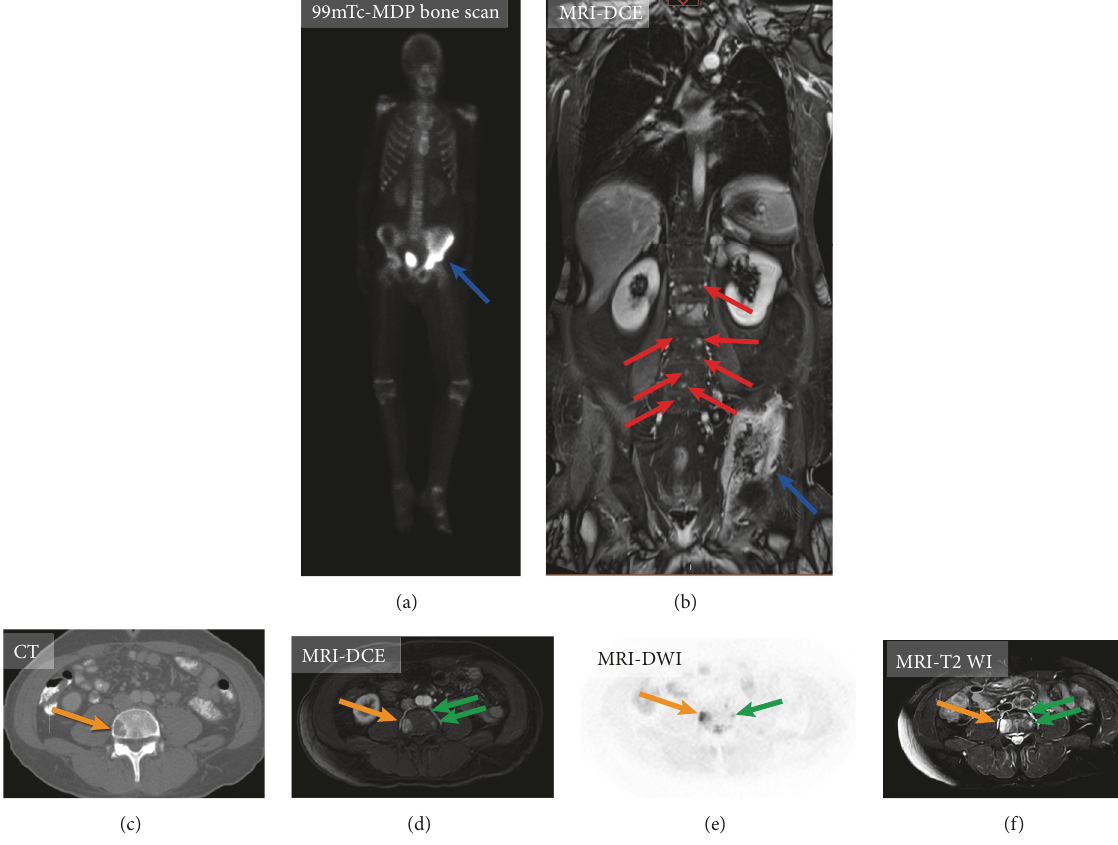
Figure 10: Imaging of bone metastases in medullary thyroid carcinoma on two different patients. Patient A (a-b). 99m-Tc-MDP bone scan (a) and whole-body contrast-enhanced magnetic resonance imaging (MRI), T1 weighted images (DCE) (b). MRI demonstrates improved visualization of metastatic lesions involving the left iliac bone (blue arrow) and clear visualization tiny bone metastases in the spine (red arrows). Patient B (c-f). Visualization of small bone metastases. Axial contrast-enhanced computed tomography (CT) at the level of L1 shows single lytic metastases in the right aspect of the vertebral body (orange arrow) (c). Axial contrast-enhanced MRI, T1 weighted images (DCE) (d), axial MRI diffusion-weighted sequence (e), and axial MRI, T2 weighted images (f) can detect additional small spinal metastases, which are not visualized on CT (green